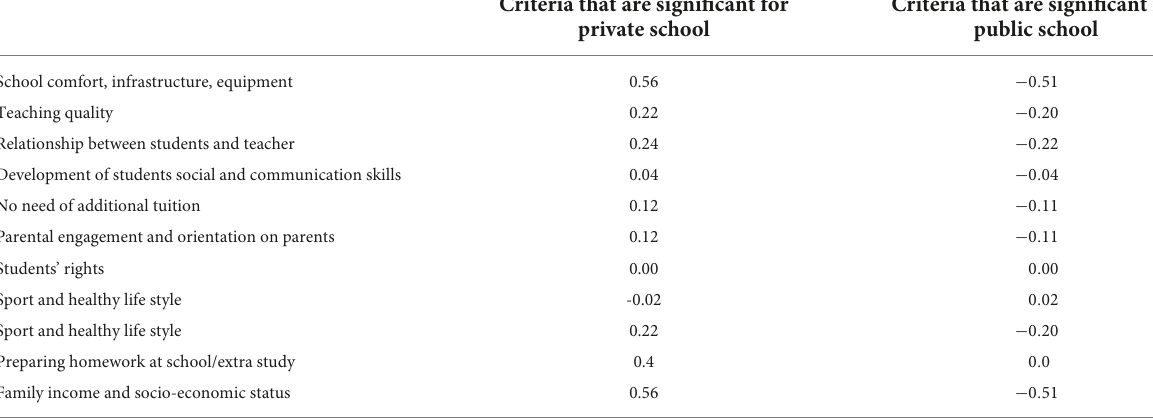
Criteria that are significant for private school